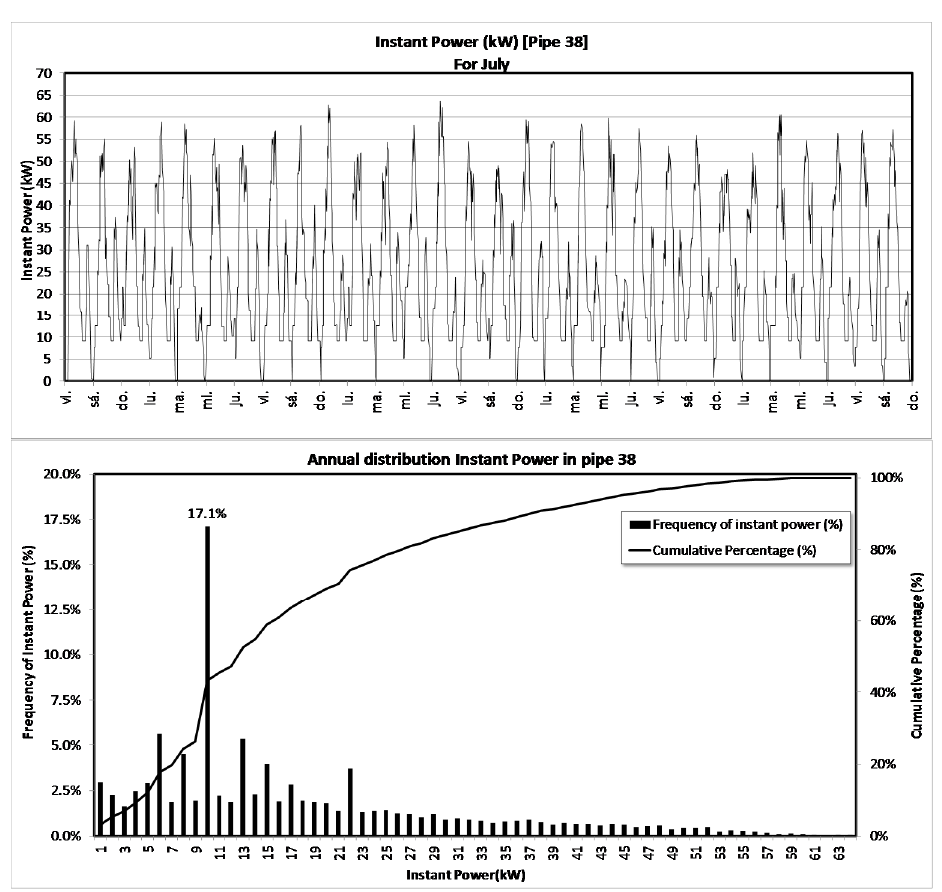
Figure 19. Potential Power in line 38. Table 2. Estimated energy recoverable in lines on the irrigation